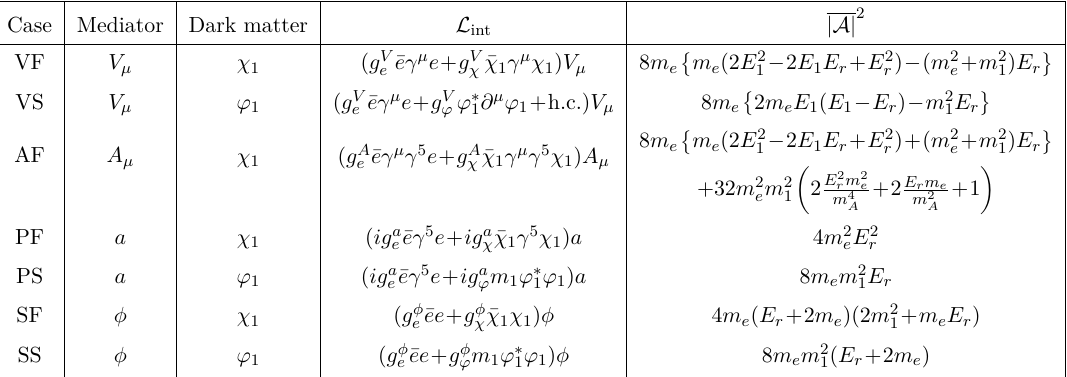
Table 1 . Example scenarios associated with the renormalizable and Lorentz-invariant interaction between BDM and electron that we consider in this study. V vector, pseudo-scalar, scalar mediators, respectively, while χ (complex-)scalar dark matter. For the PS and SS cases, the scale of mediator couplings to dark matter is normalized to the mass of BDM for